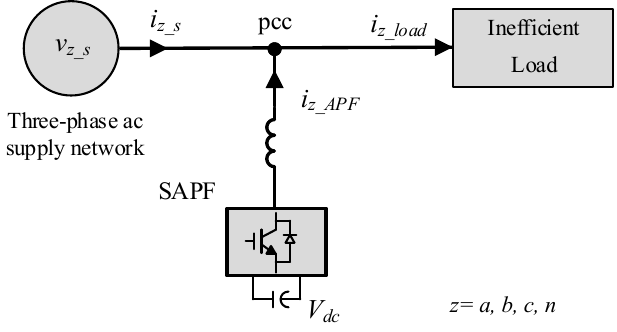
Figure 1. Shunt active power filter (SAPF) connection.